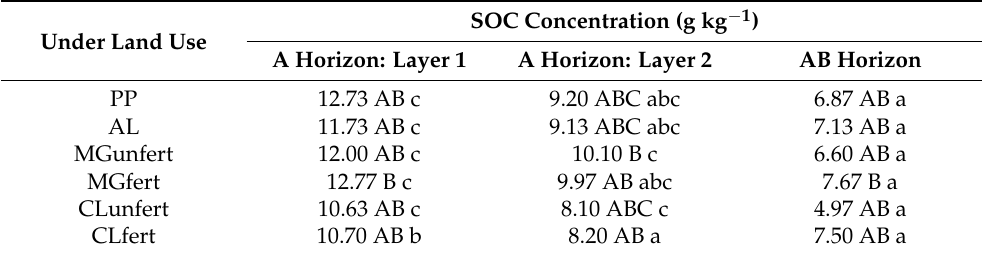
Table 4. SOC concentrations (g kg − 1 ) in A and AB horizons in soils of different types of land use (2018).